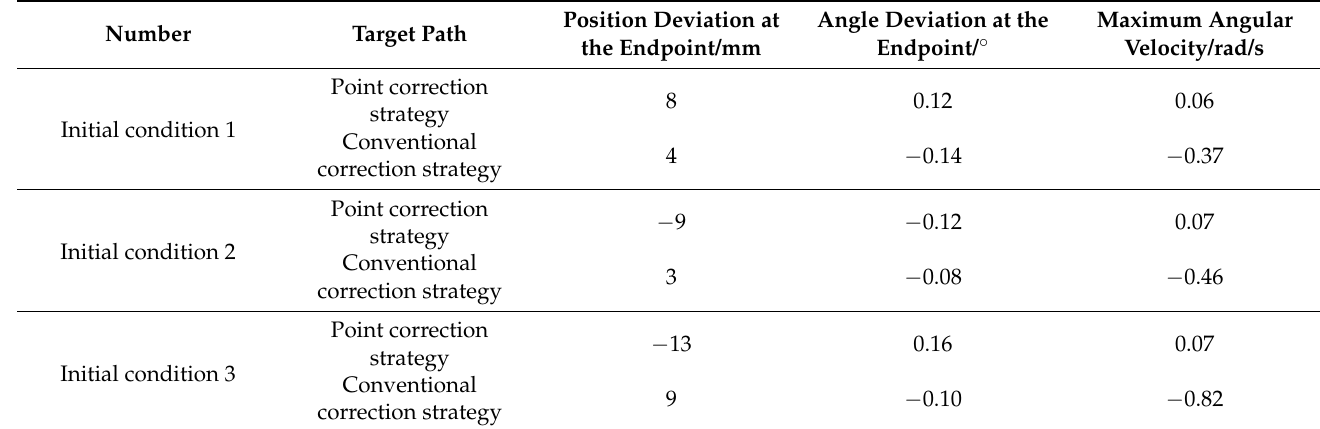
Table 6. A performance comparison of different correction